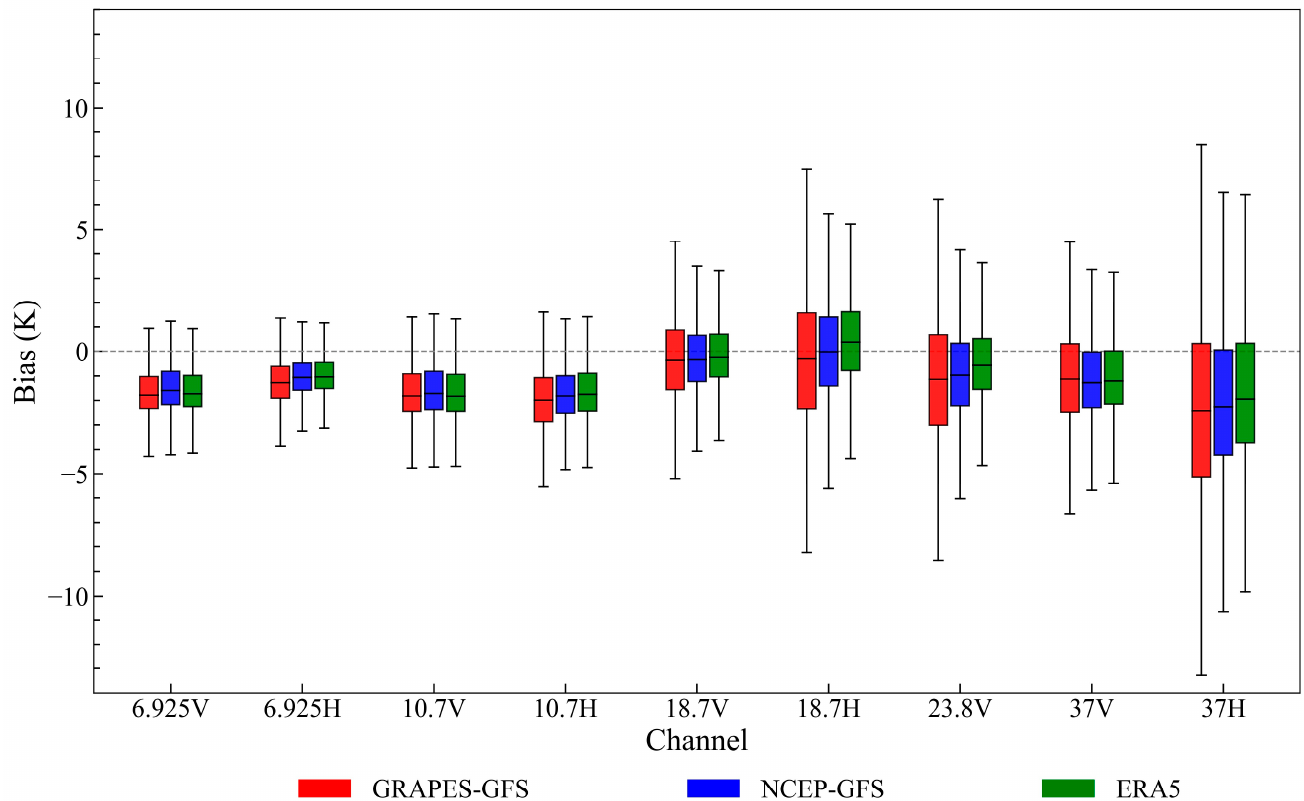
Figure 7. Boxplots of O-B for all SMR channels from 10 July 2021 to 10 August 2021. All statistics are conducted after applying the QC procedure described in Section 2.4. The green box represents the O-B statistics based on ERA5 (O-B ERA5 ), the blue box represents the O-B statistics based on NCEP-GFS (O-B NCEP ), and the red box represents the O-B statistics based on GRAPES-GFS (O-B GRAPES ). The horizontal bars in the boxplots show the five-number summaries of a distribution (namely, minimum, first quartile, median, third quartile, and maximum).